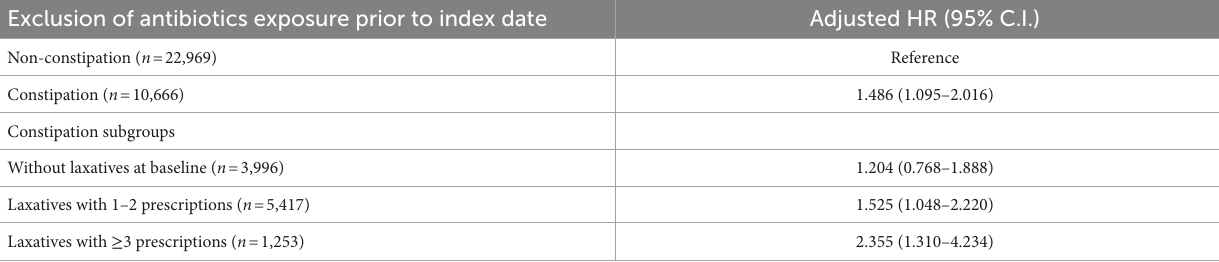
TABLE 5 Sensitivity analysis for exclusion of antibiotics